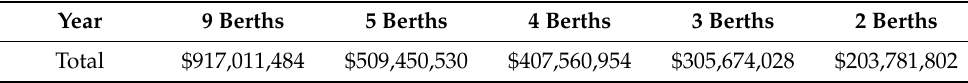
Table 12. Estimated operating costs from 2020 to 2049 (units: U.S. dollars).